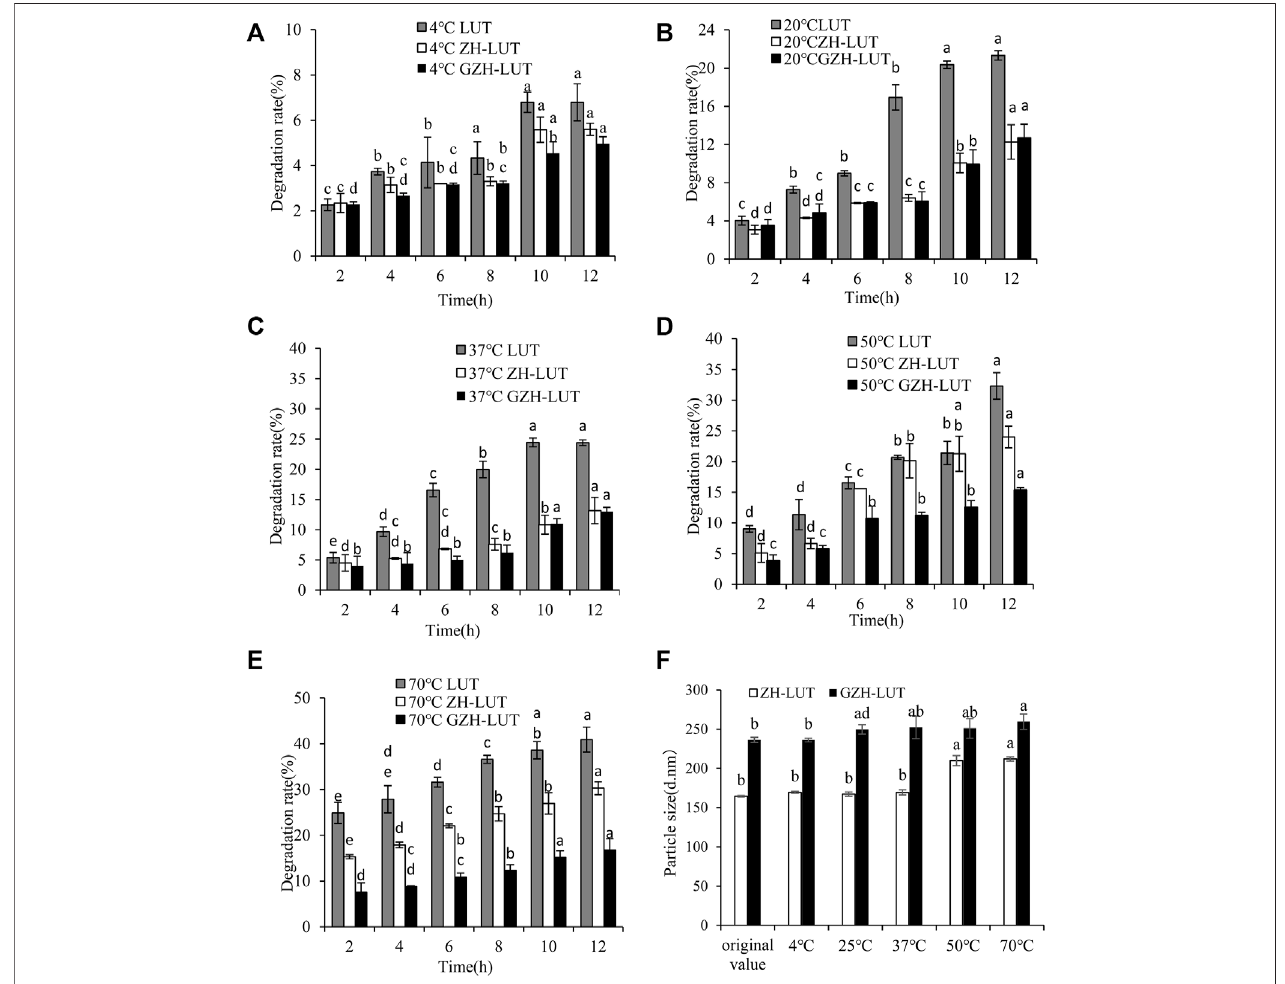
FIGURE 7 | Effects of temperature on the heat stability of free lutein, ZH-LUT and GZH-LUT nanoparticles (A − F) .